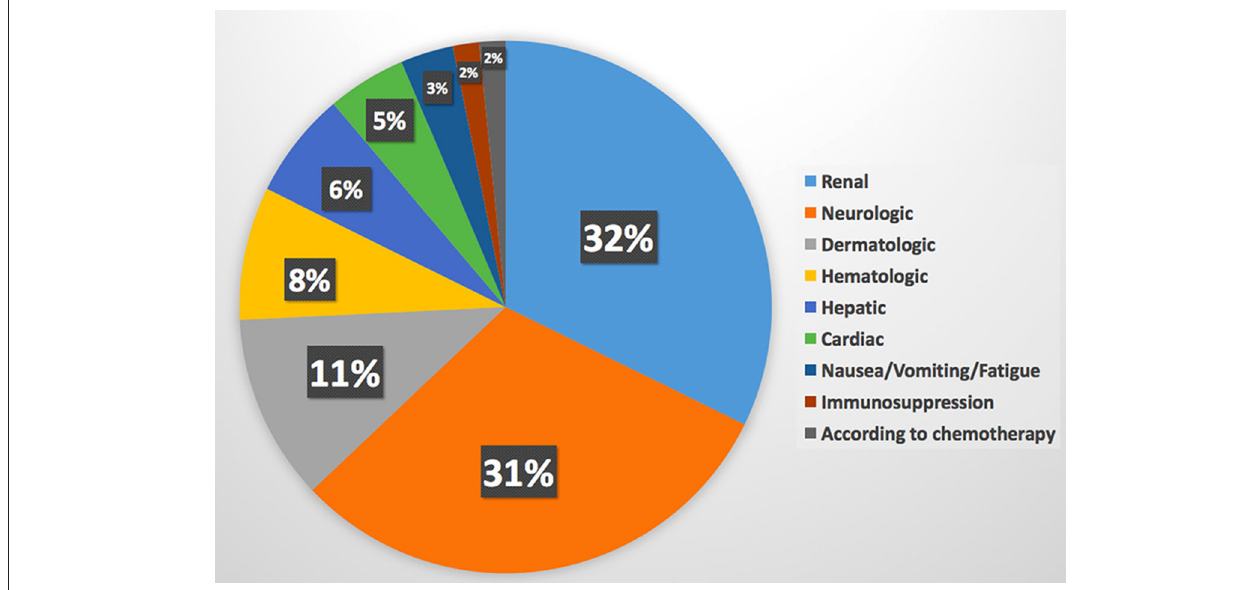
FIGURE 5 | Most common complications of chemotherapy. Cardiovascular disease is the sixth complication of chemotherapy.